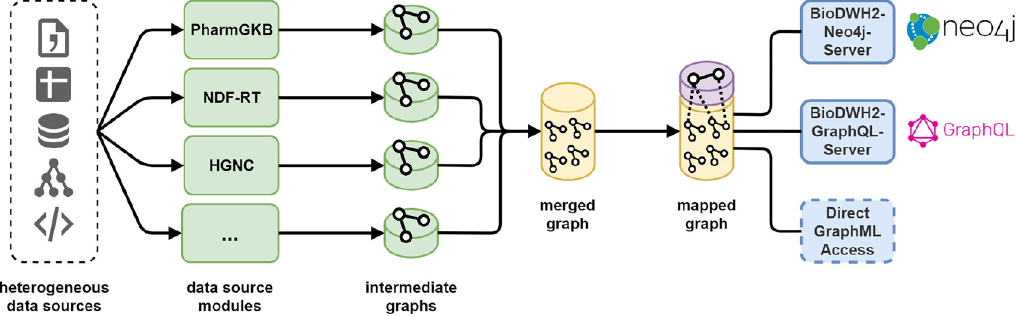
Figure 8: The complete overview of the BioDWH2 data flow from their heterogeneous sources, via the data source modules and intermediate graphs, towards the merged and mapped graphs, and finally the access for